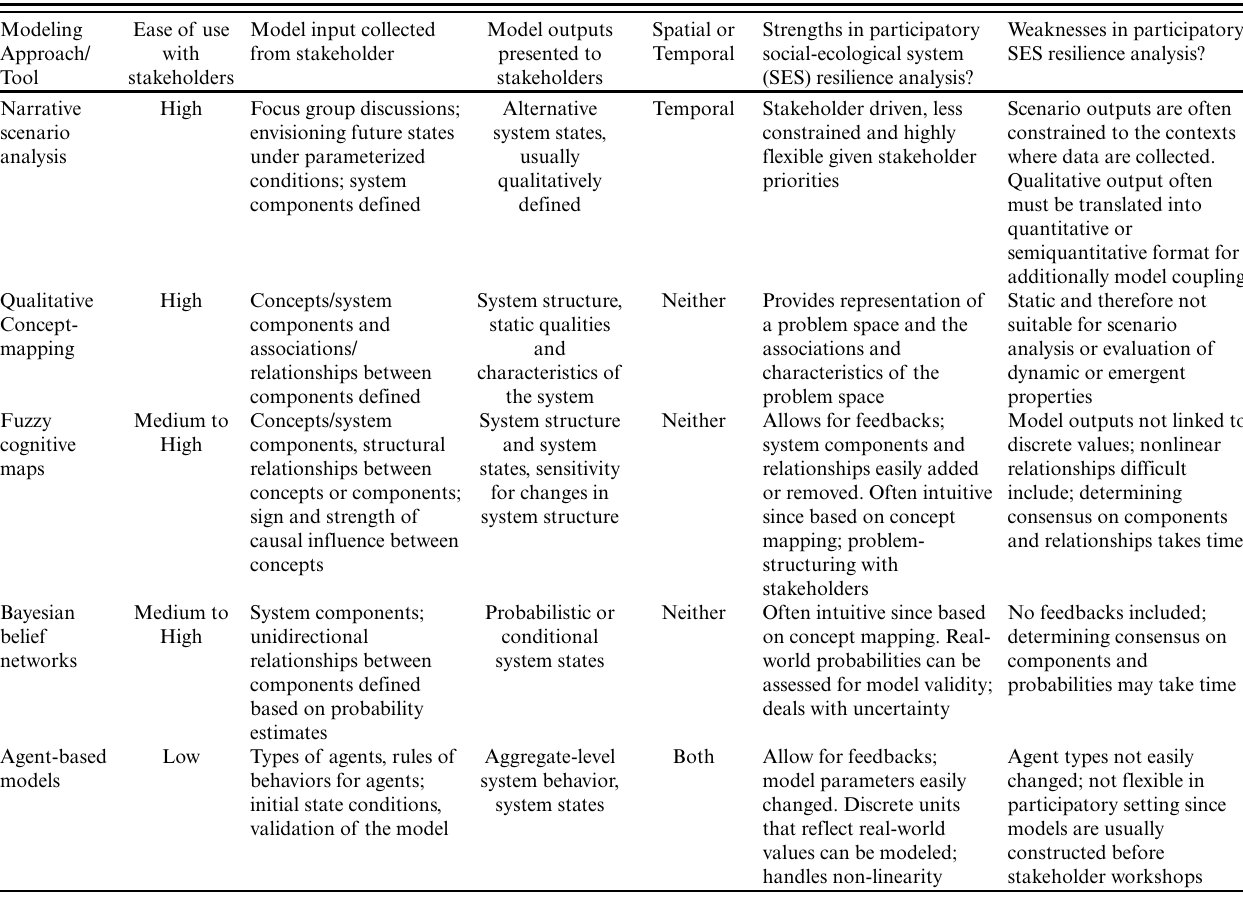
Table 3 . Comparison of participatory modeling as they relate to participatory resilience